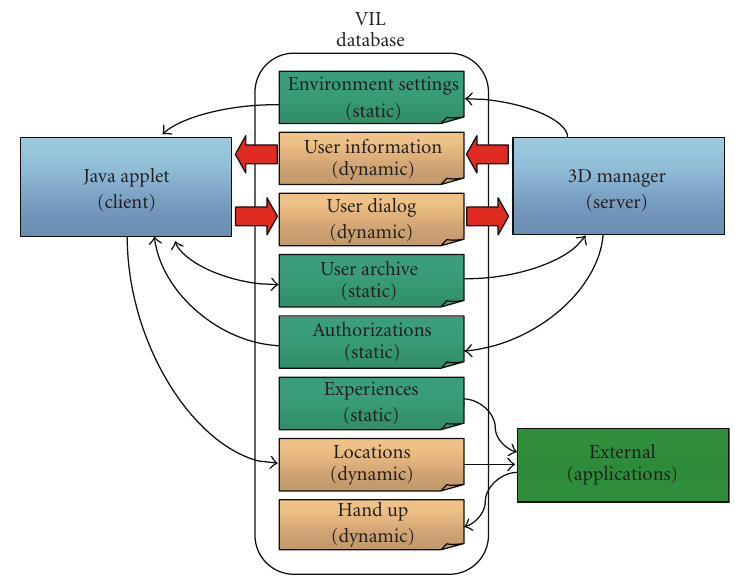
Figure 9: The VIL database.